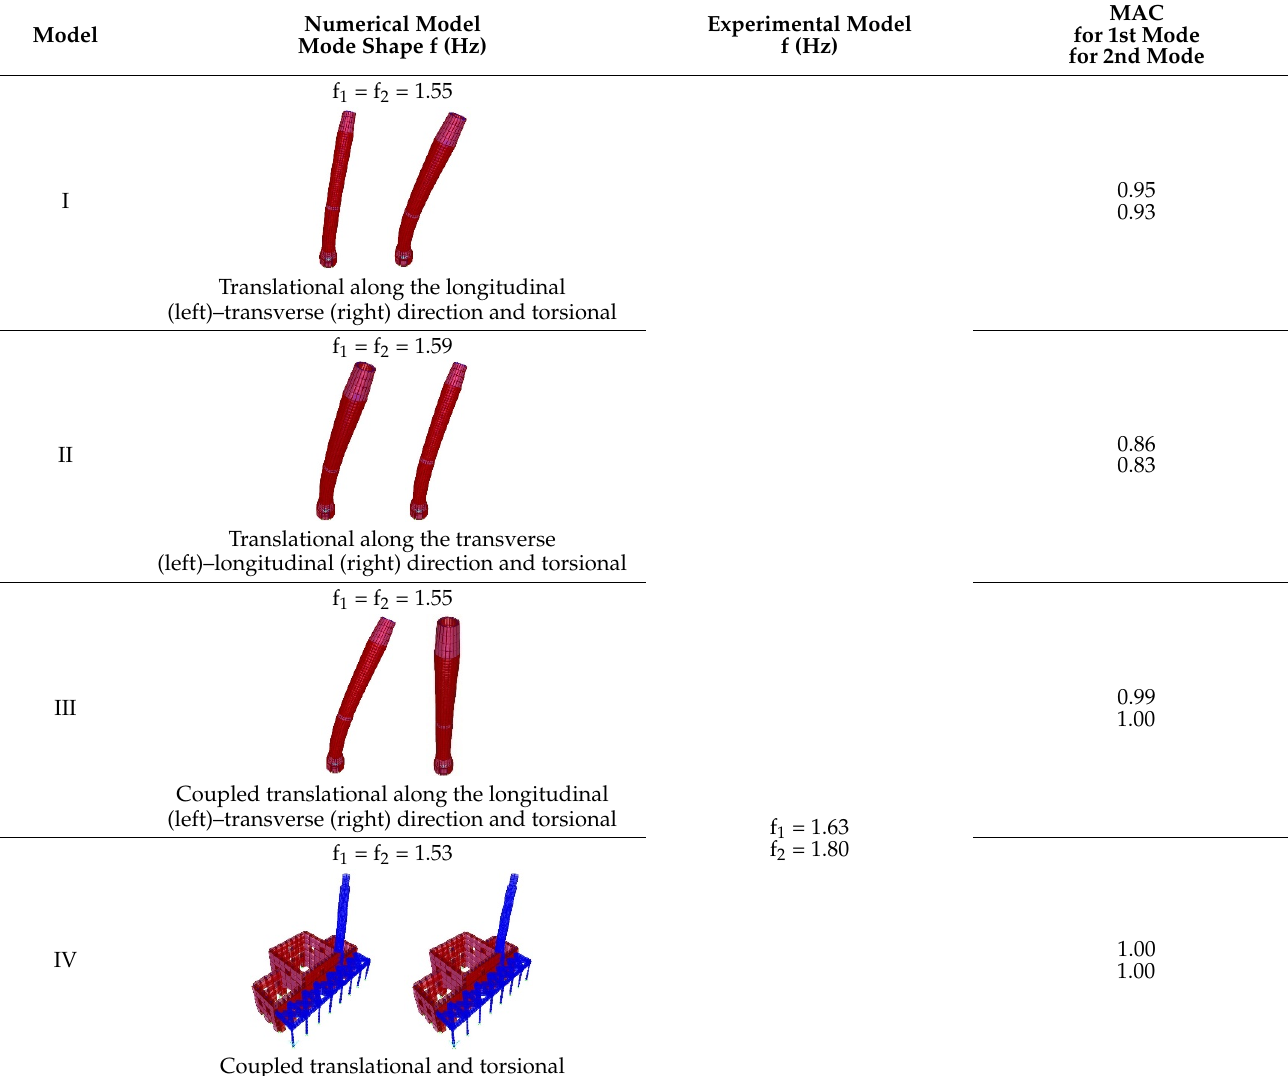
results give about 1.9–7.9% higher frequencies for the first mode. In contrast, for the sec- ond mode, the observed frequencies are almost 11.7–16.5% higher. Table 3. Comparison of the considered numerical FEMs of the monument and the experimental results using the SSI method (f: frequency).